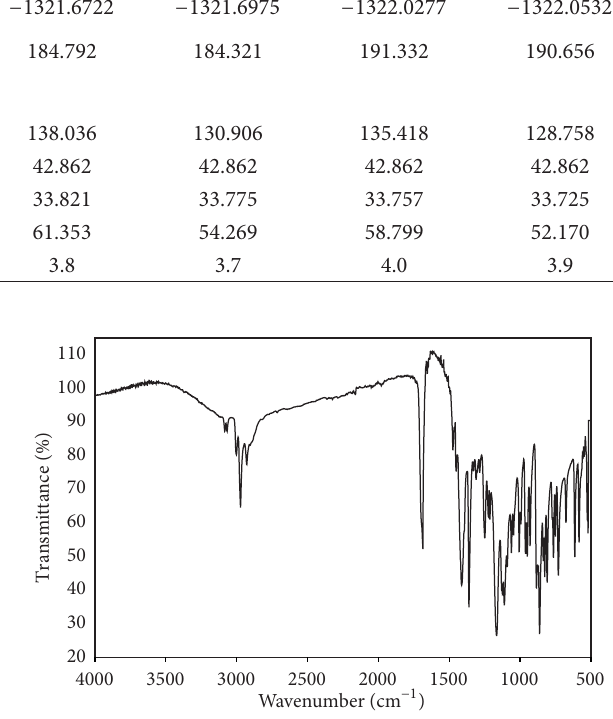
F 3: FT-IR spectrum of tert -butyl 3a-chloroperhydro-2,6a- epoxyoxireno[ e